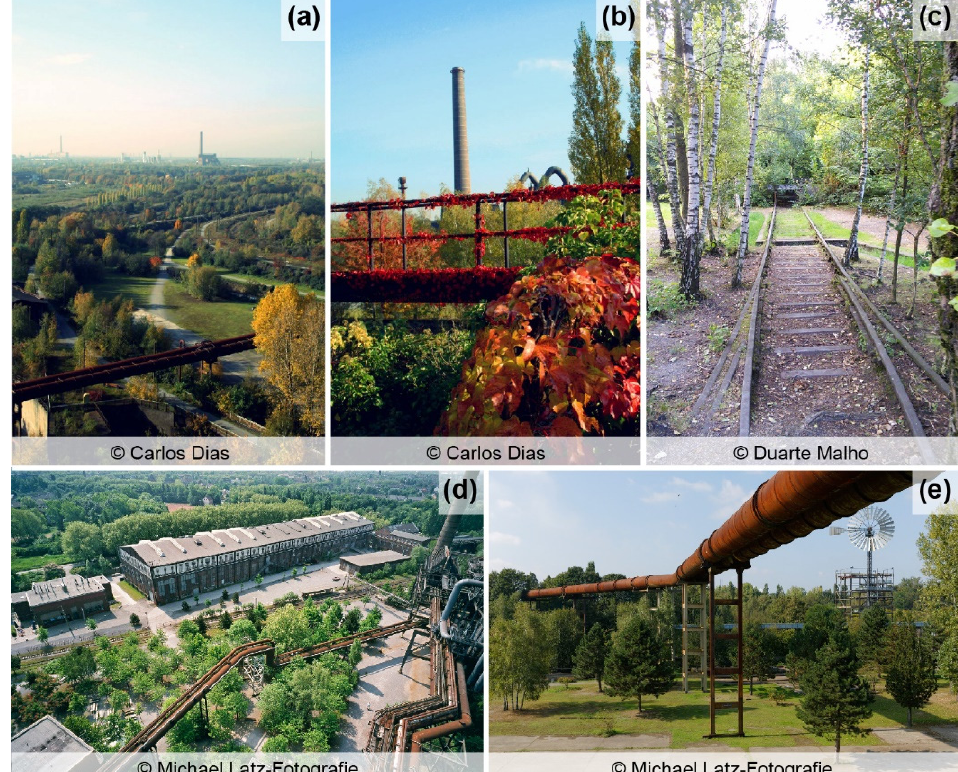
Figure 1. ( a ) The post-industrial landscape and scenery at the Landscape Park Duisburg-Nord; ( b ) Vegetation evolving and taking over existing elements; ( c – e ) Railways, machinery, old pipes, and industrial structures merged into the landscape and coexisting with the involving novel plant com- munities. Reprinted (Figure 1d–e) with permission from ref. [66]. Copyright 2021 Michael Latz-Fo- tografie.